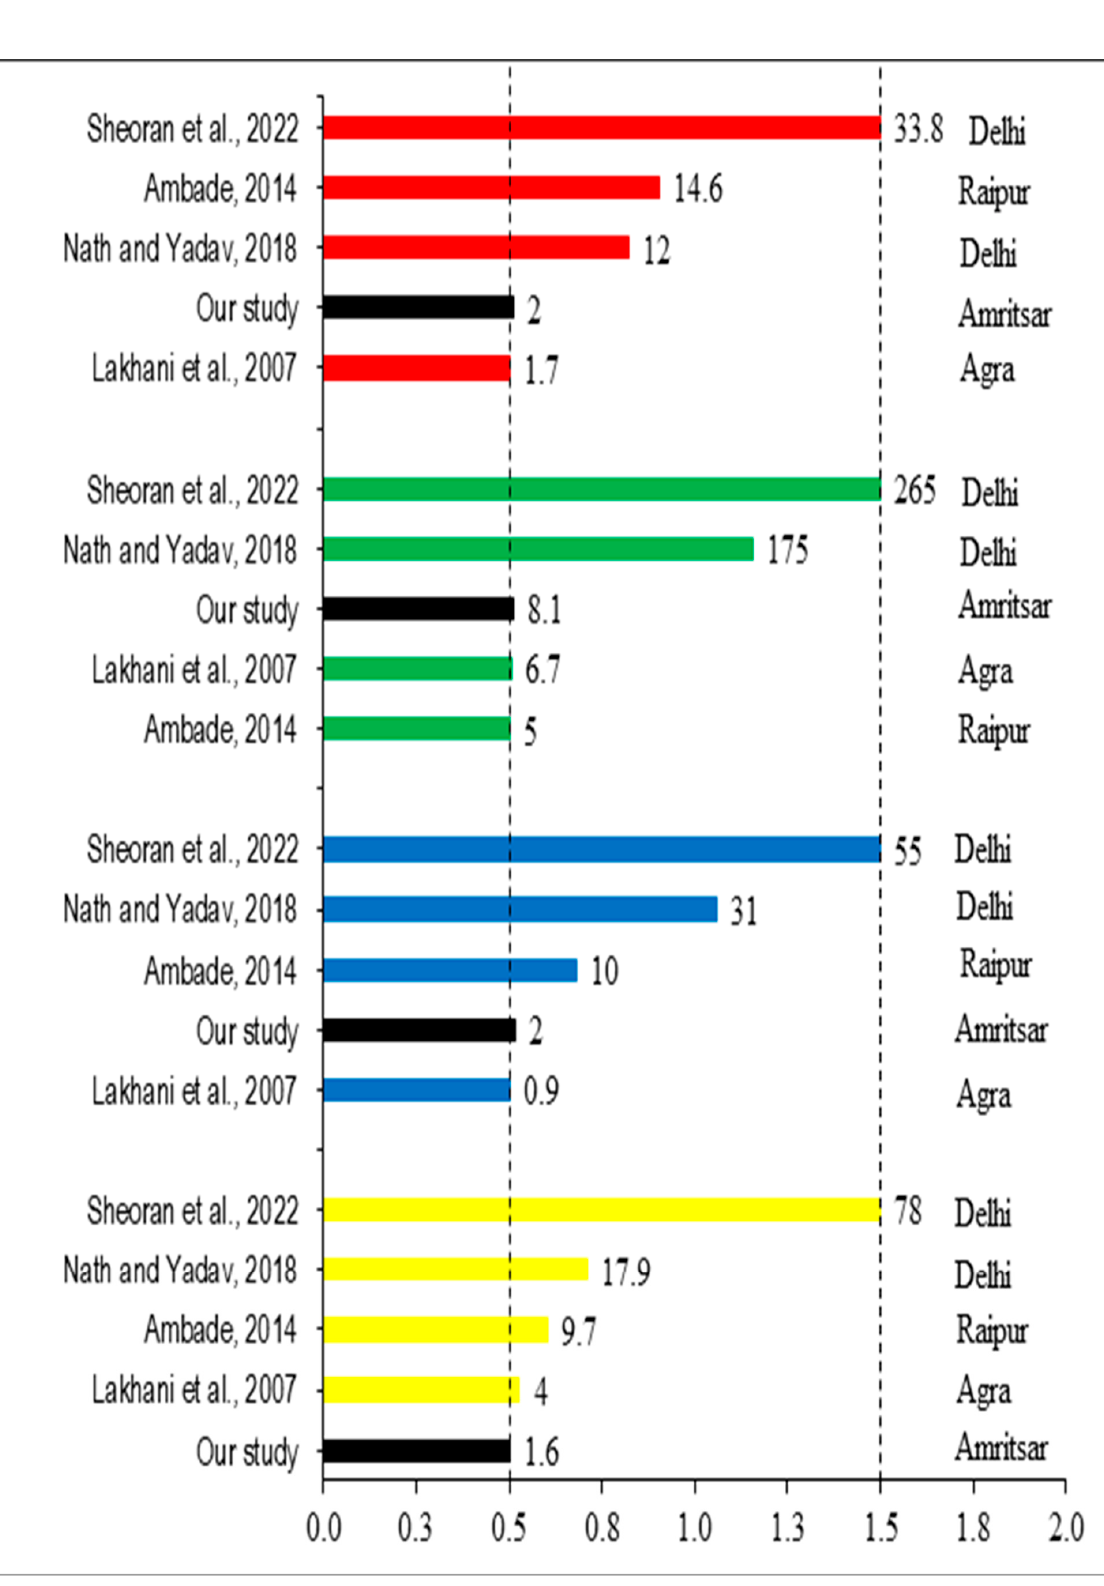
Figure 5. Review graph of cationic concentration (mg/L) on normalized scale (0.5–1.5) for magnesium (red), calcium (green), potassium (blue) and sodium (yellow) in fog water studies, (Black color represent own study). References included are [33,39,40,51].